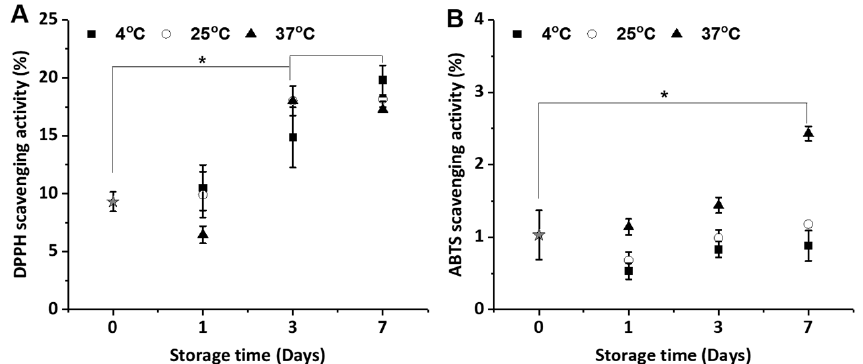
Figure 3. Antioxidant activity of trans -cinnamaldehyde ( t CIN) and β -cyclodextrin ( β -CD) inclusion complex (CI). ( A ) DPPH and ( B ) ABTS radical-scavenging activities were measured at different storage temperatures (4 °C, 25 °C and 37 °C) for 7 days. The CIs were obtained by molecular inclusion at 1:1 molar ratio of t CIN and β -CD. Data are the mean ± standard deviation (SD). * p < 0.05 versus the radical-scavenging ability of the CIs at day 0 (initial CIs). DPPH, 1,1-diphenyl-2-picrylhydrazyl; ABTS, 2,20-azino-bis(3-ethylbenzothiazoline-6-sulphonic)